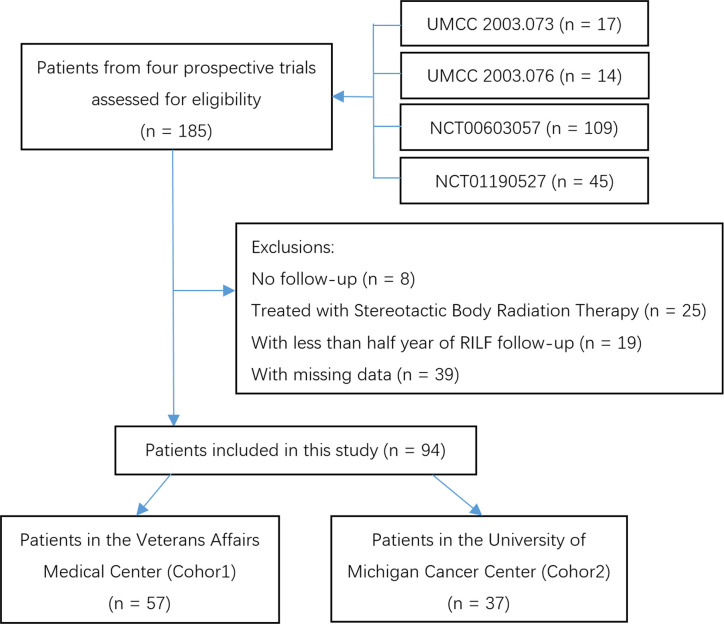
Study flow chart.